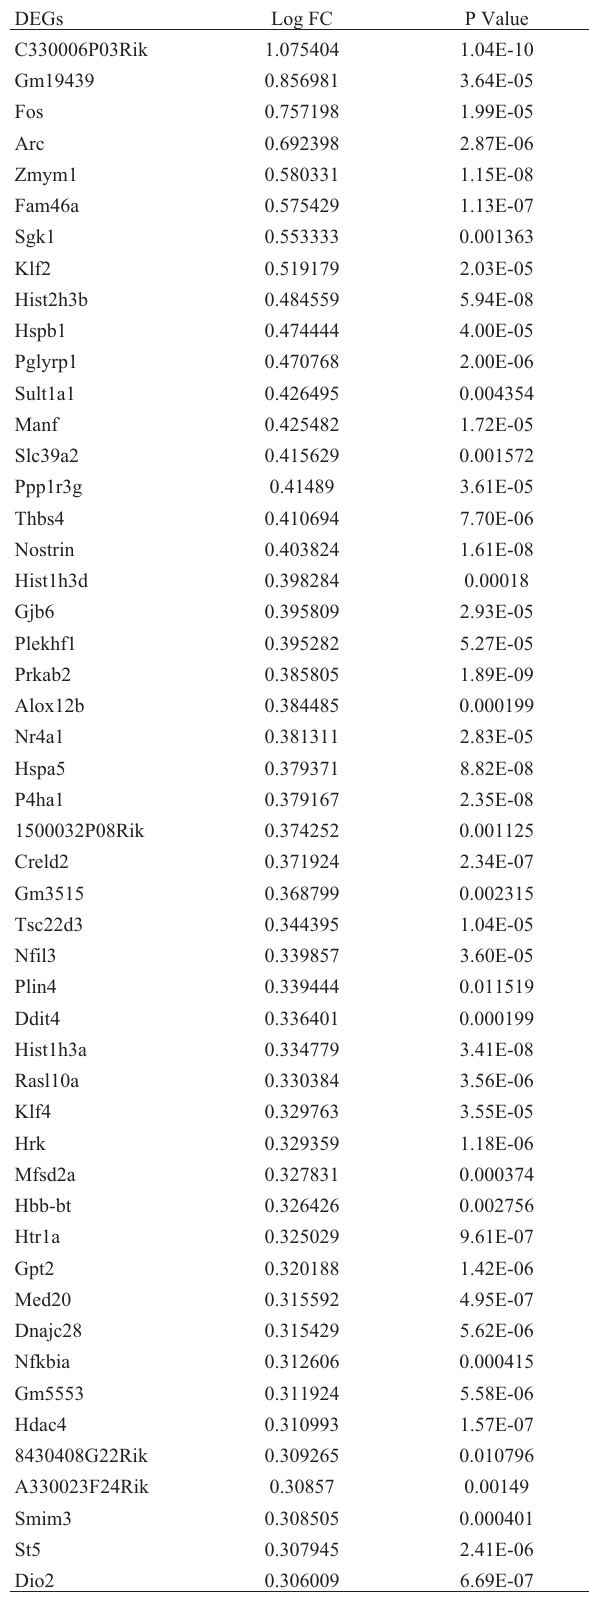
Table 2 - The top 50 up-regulated DEGs in sleep deprivation mice com- pared with non-sleep-deprived control